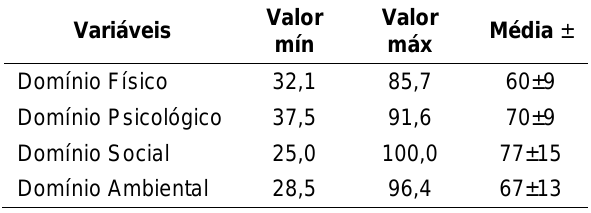
Tabela 2. Qualidade de Vida dos